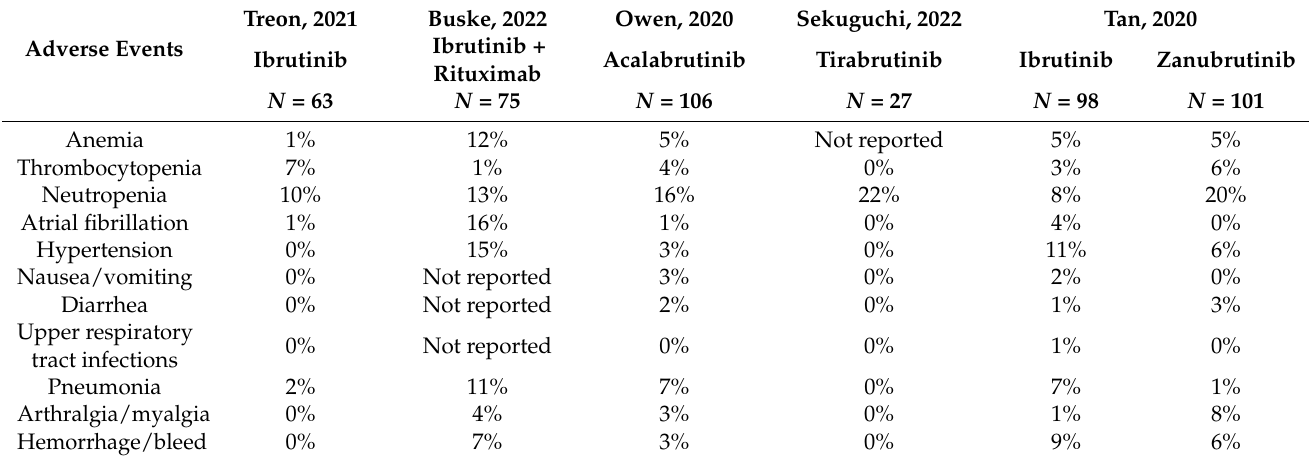
Table 2. Incidence of grade 3–4 adverse events of interest for BTKi in